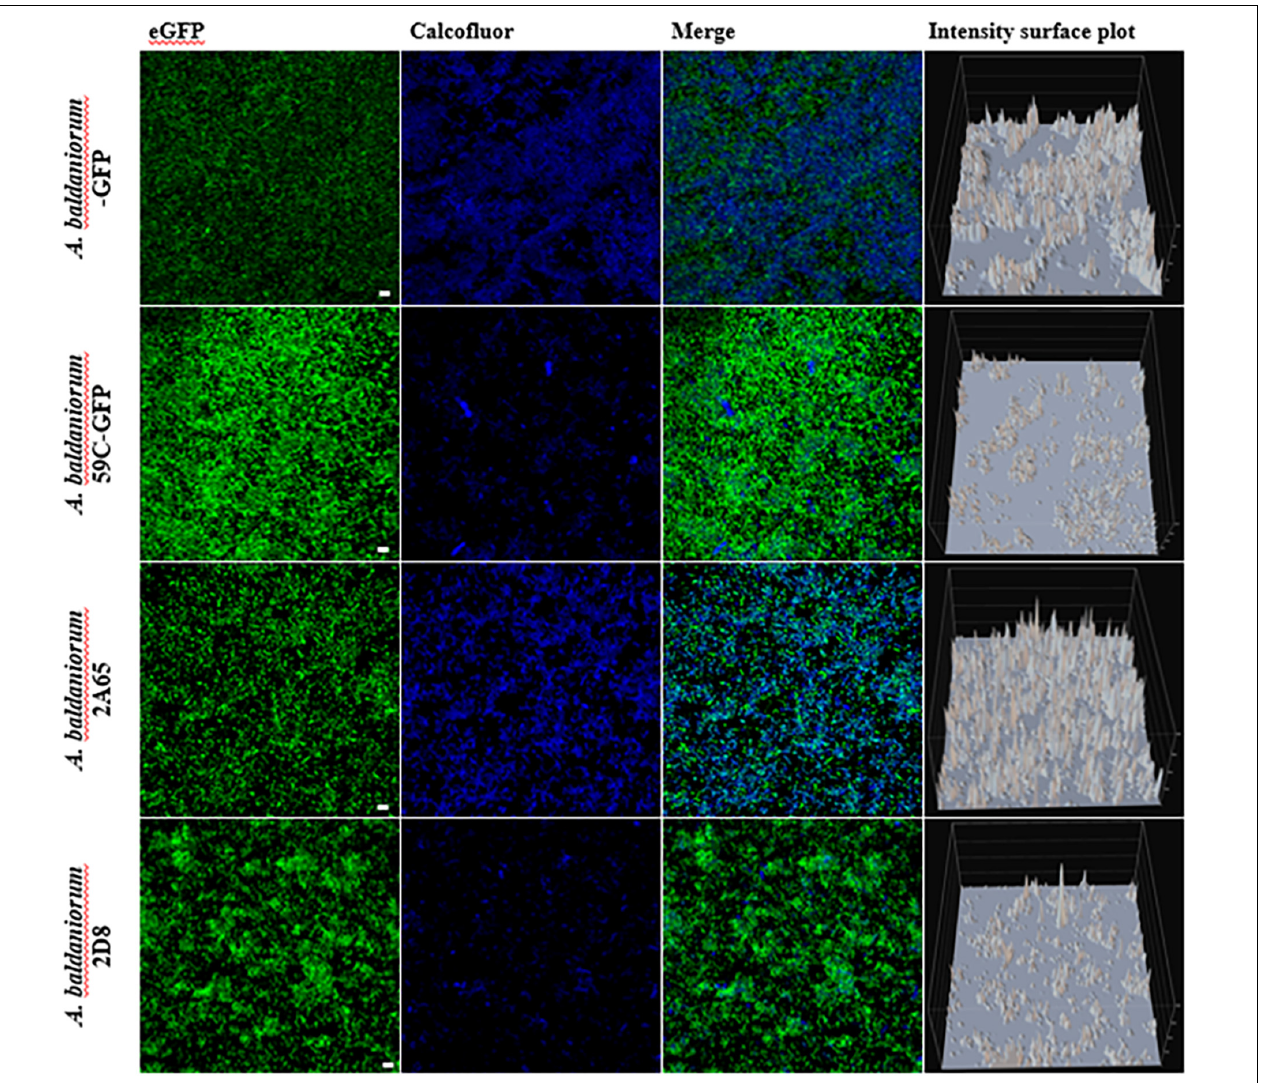
FIGURE 2 | Biofilm formation analysis with confocal microscopy. Maximum projection confocal laser scanning microscopy images of 5-day old static biofilms grown in NFB media and tagged with an eGFP fluorescent protein (shown in green) and dyed with calcofluor CWC (shown in blue). The A. baldaniorum WT, A. baldaniorum 59C mutant, A. baldaniorum C21 mutant complemented with cdgC gene, A. baldaniorum C87 mutant without cdgC gene strains. Scale bar 10 µ m. Intensity surface plot corresponding to the emitted fluorescence by CWC is shown in the last panels. The Nikon Eclipse Ti-E C2+ (CLSM) was used with a 60x Plan lambda objective. These are representative images from at least three independent